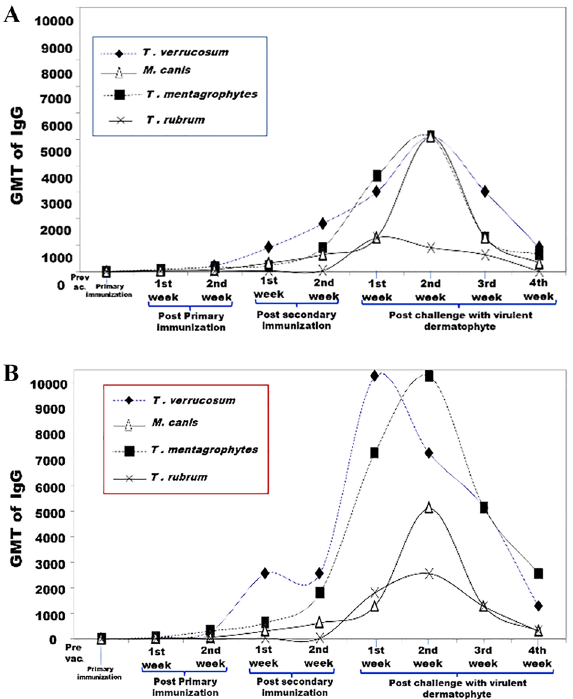
Figure 2. ( A ) ELISA GMT of anti- T. verrucosum , T. mentagrophytes , M. canis , and T. rubrum -specific IgG in sera of Guinea pigs immunized with the non- adjuvanted inactivated polyvalent dermatophyte vaccines; ( B ) ELISA GMT of anti- T. verrucosum , T. mentagrophytes , M. canis , and T. rubrum IgG in sera of Guinea pigs immunized with the non- adjuvanted living polyvalent dermatophyte